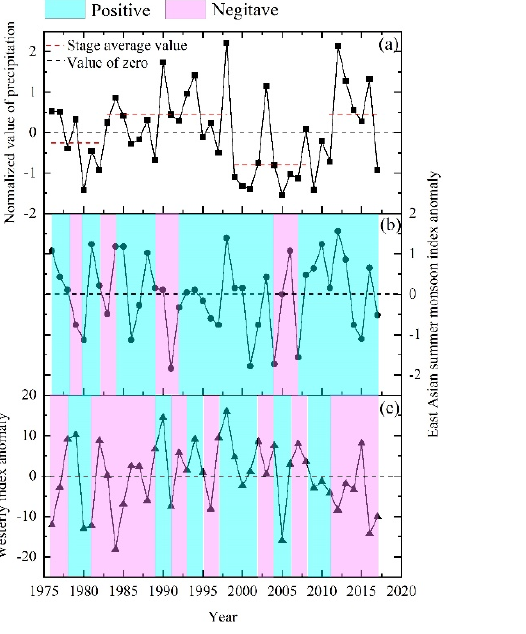
Figure 8. The relationship of normalized value of precipitation and EASMI anomaly and WI anomaly in MP. ( a ) Normalized value of precipitation, ( b ) EASMI anomaly, ( c ) WI anomaly, ( d ) Between EASMI and WI, this is, the opposite signs (+ − / − +), the signs are both negative ( − − ), and signs same as positive (+ +). Positive indicates that the change trend of EASMI or WI is the same as that of normalized value of precipitation, while negative indicates that the change trend of EASMI or WI is opposite to that of normalized value of precipitation.